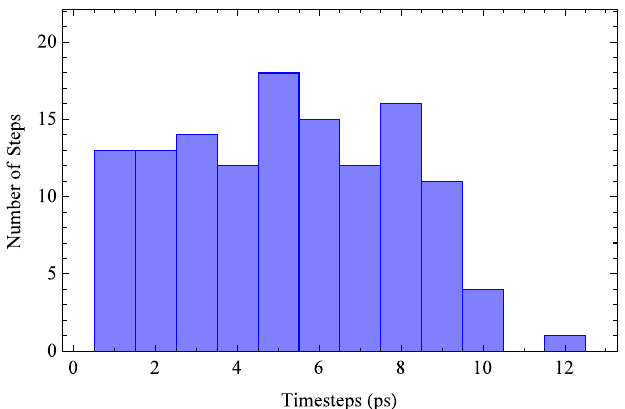
FIG. 2. An example showing the distribution and frequency of the time steps of a particle taken by the Simò integrator as subtimesteps of a PHAD time step h ¼ 1 . 7